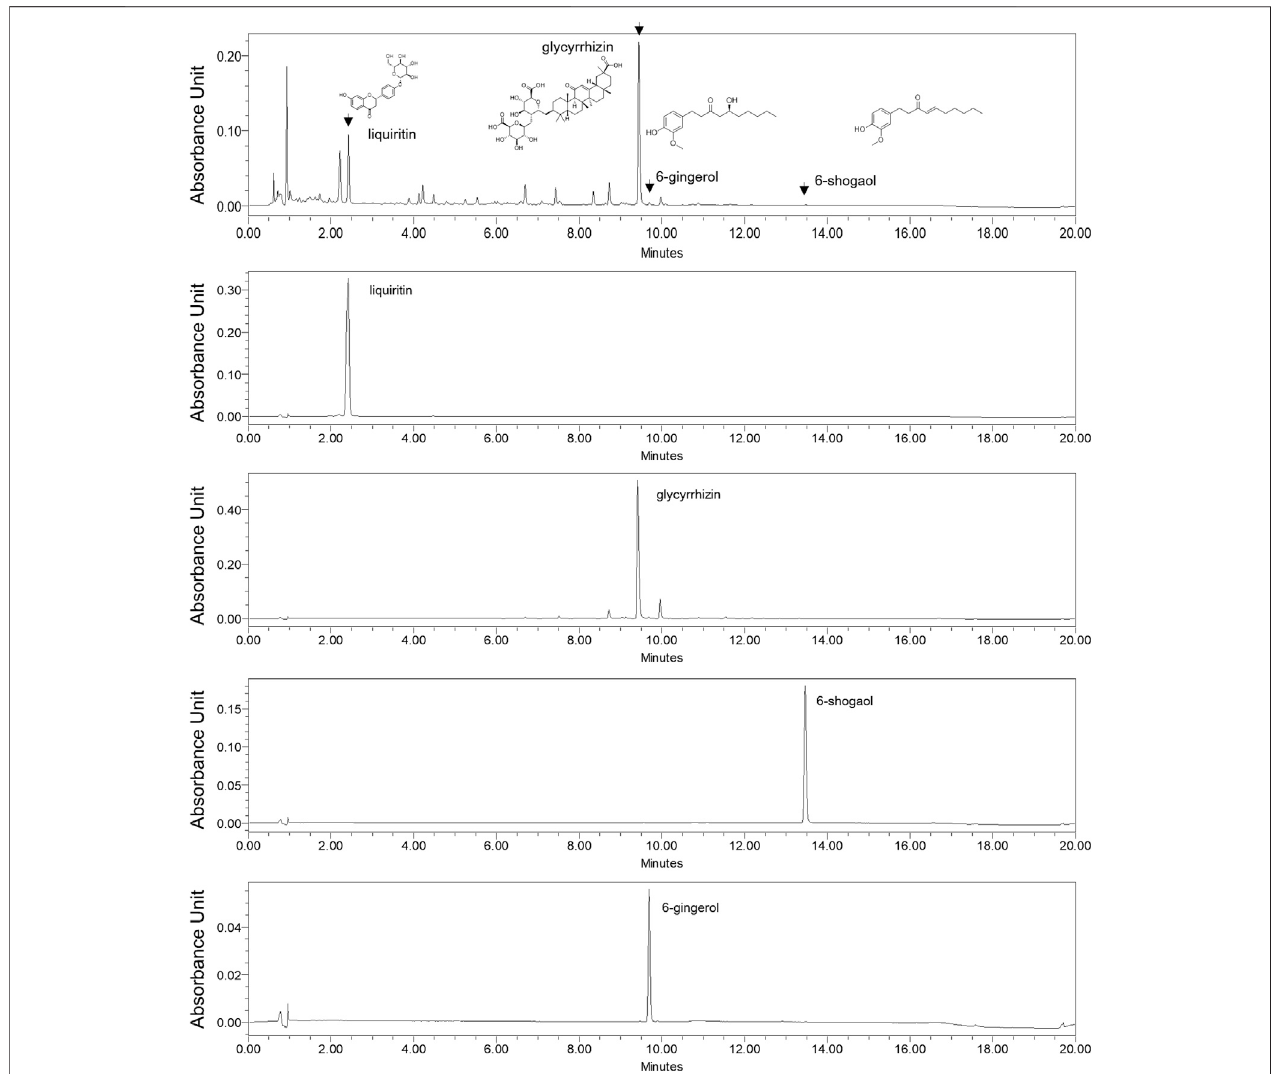
FIGURE 2 | Liquid Chromatography-Mass Spectroscopy analysis of licorice and dried ginger decoction (LGD) and standard compounds.